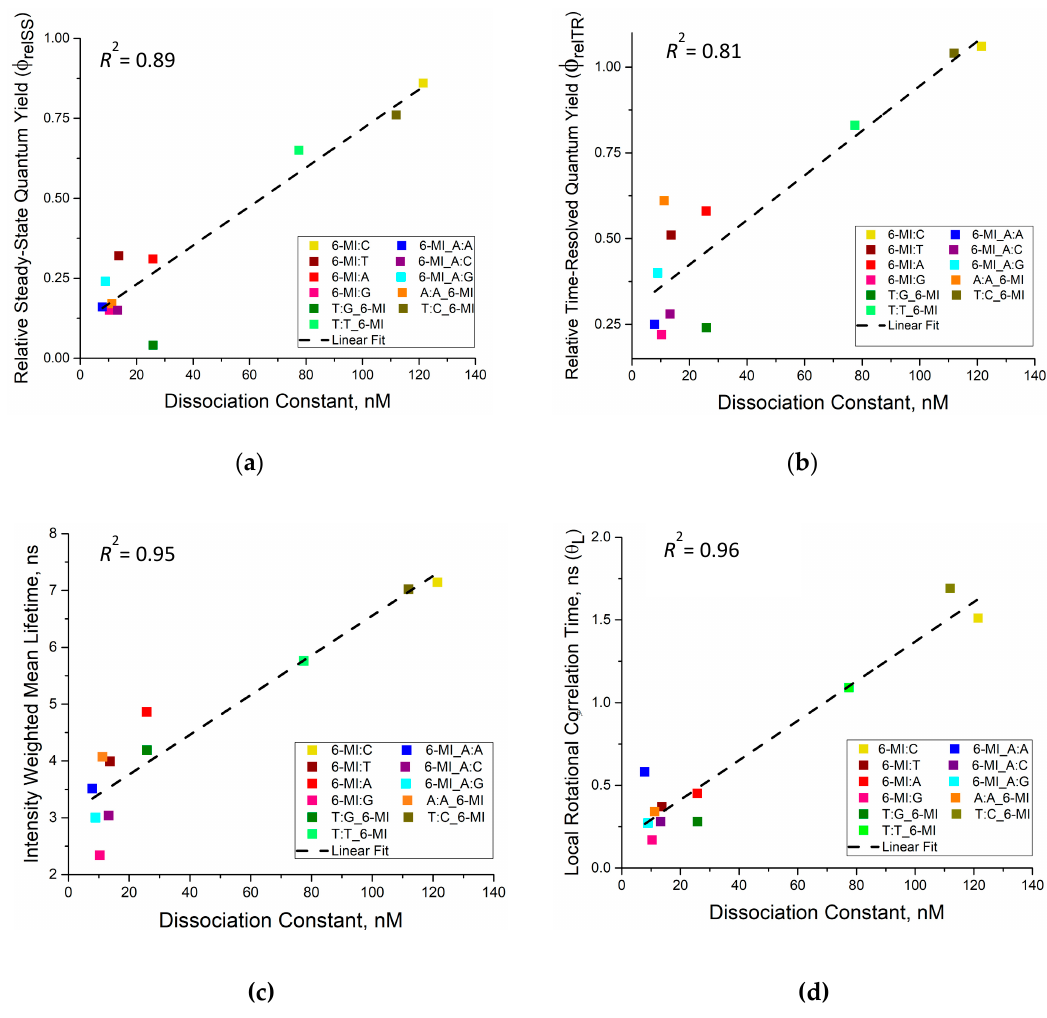
Figure 8. Linear relationships between ( a ) steady state quantum yield, ( b ) time-resolved quantum yield, ( c ) mean excited-state lifetime ( τ m ) and ( d ) local rotational correlation time ( θ L ) of 6-MI and the dissociation constant ( K D ) of Msh2-Msh6 for various mismatched duplexes. Mismatched bps with low quantum yields ( φ ), shorter mean lifetimes ( τ m < 5 ns) and shorter local rotational correlation times ( θ L < 0.5 ns), indicative of high local flexibility and dynamics, are well-recognized by Msh2–Msh6 ( K D ≤ 25 nM).